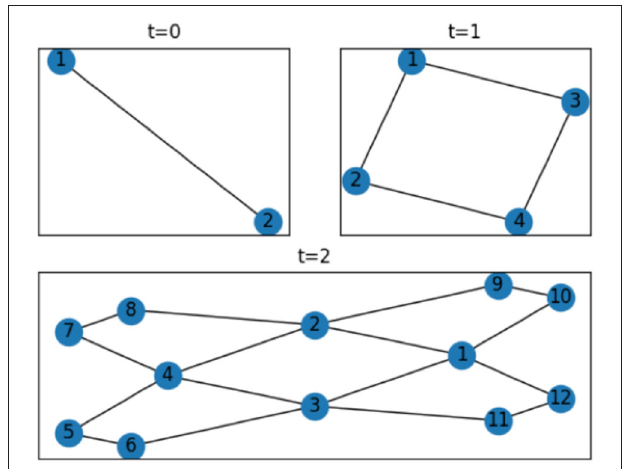
FIGURE 2 | The illustration of the network generation process when the time step is t = 0,1,2, respectively.